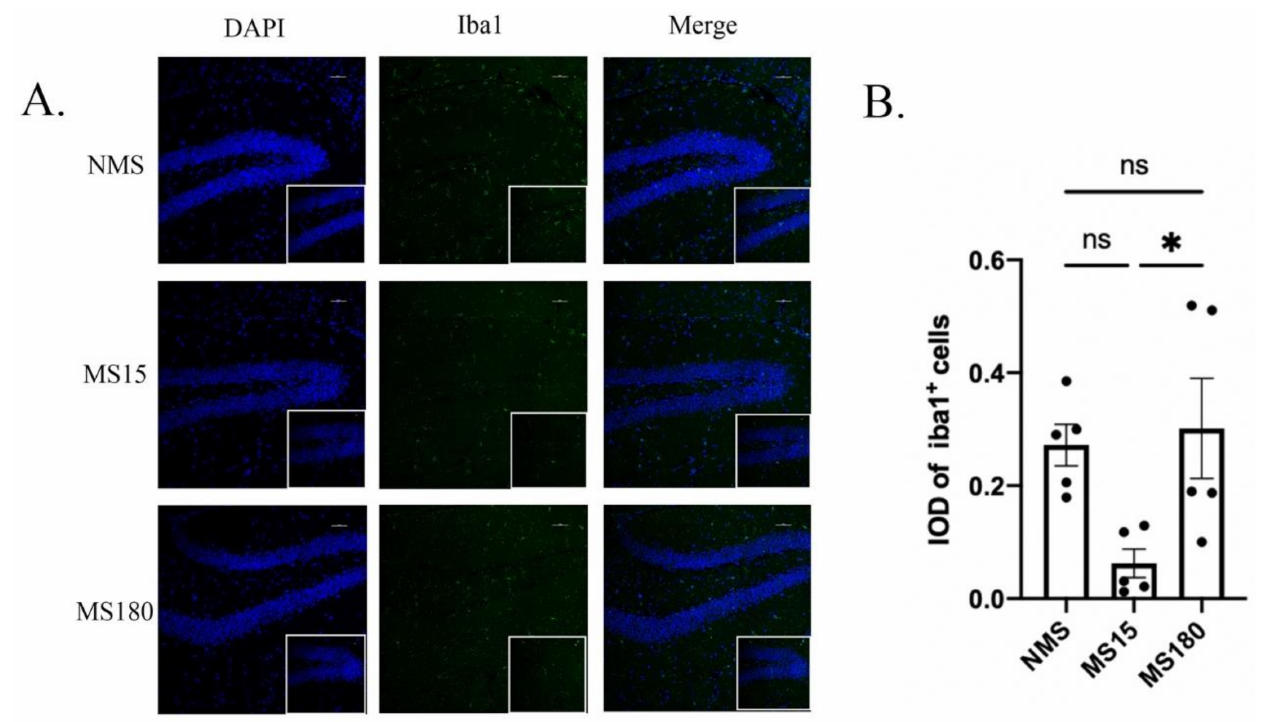
Figure 8. Iba1 immunoreactivity of microglia in hippocampus of IMQ-induced psoriasis-like female mice with different MS protocols. ( A ) Representative images of labeling for Iba1. ( B ) The integral optical density (IOD) of Iba1 + cells in hippocampus ( × 200), scale bar = 50 µ m. NMS, MS15 and MS180 groups were concluded. Each value represents the mean ± SEM. n = 5 animals per group. All 3 groups were analyzed using ANOVA followed by a post hoc analysis (ns p > 0.05, * p <